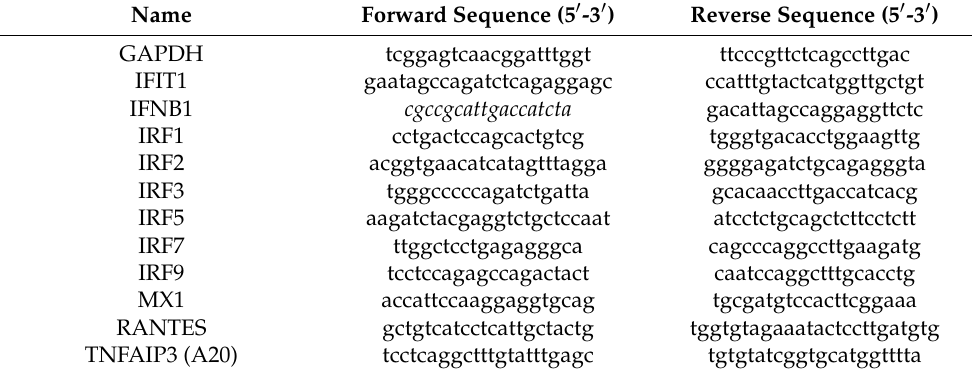
Table 3. Gene specific primers used for